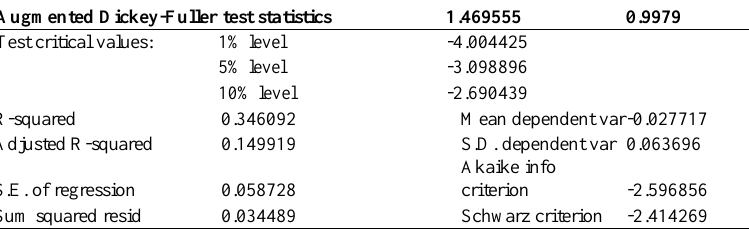
Table 3. Stationarity estimation of the ln (INC) series by the DF